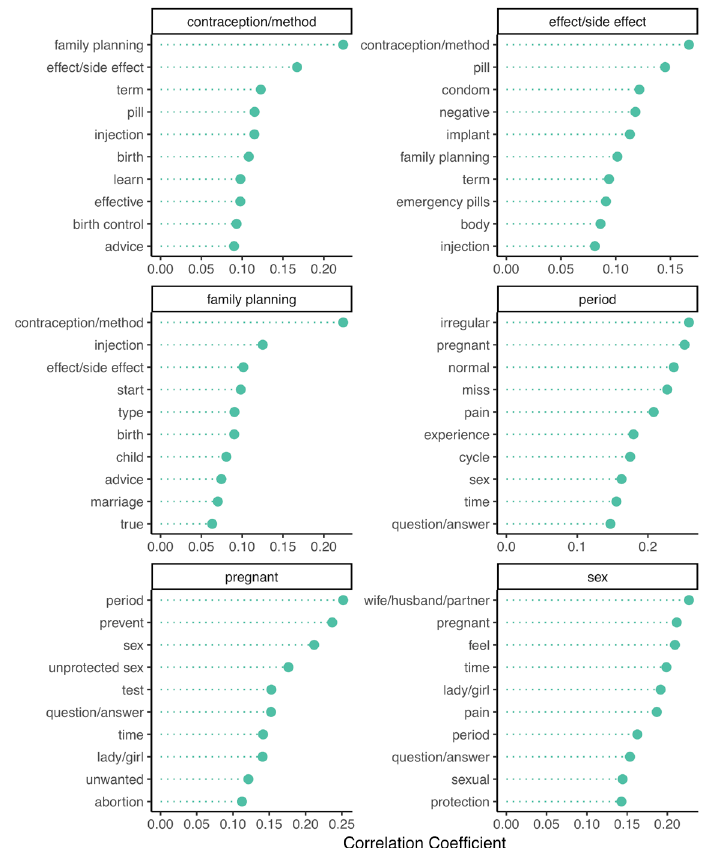
Figure 8. Top pairwise correlations (phi) between English